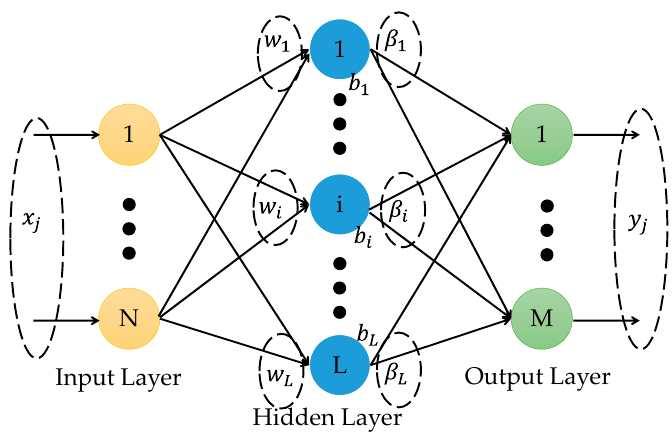
Figure 1. Basic ELM network architecture.